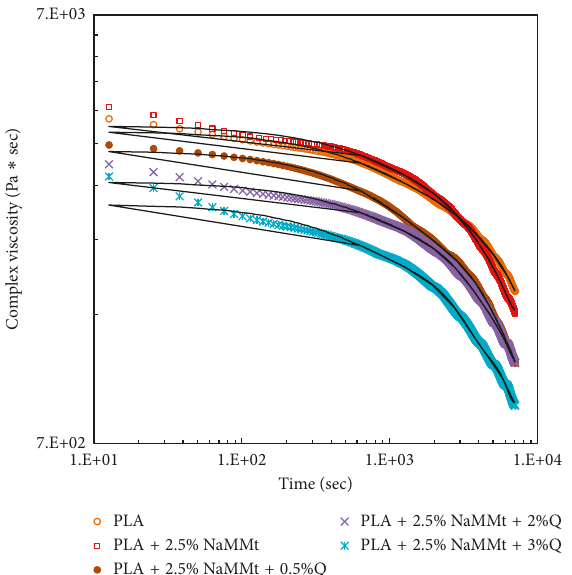
Figure 1: Complex viscosity data (symbols) and theoretical fittings (continuous lines) of neat PLA and PLA/NaMMt containing dif- ferent amounts of